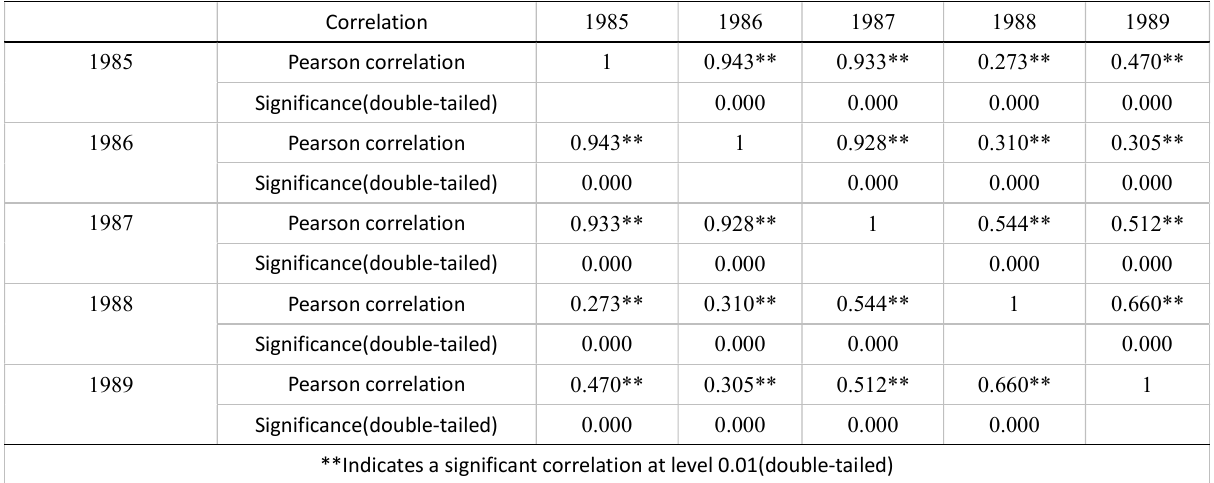
Tab.1 Correlation analysis of horizontal displacement observations of Fengman dam from 1985 to